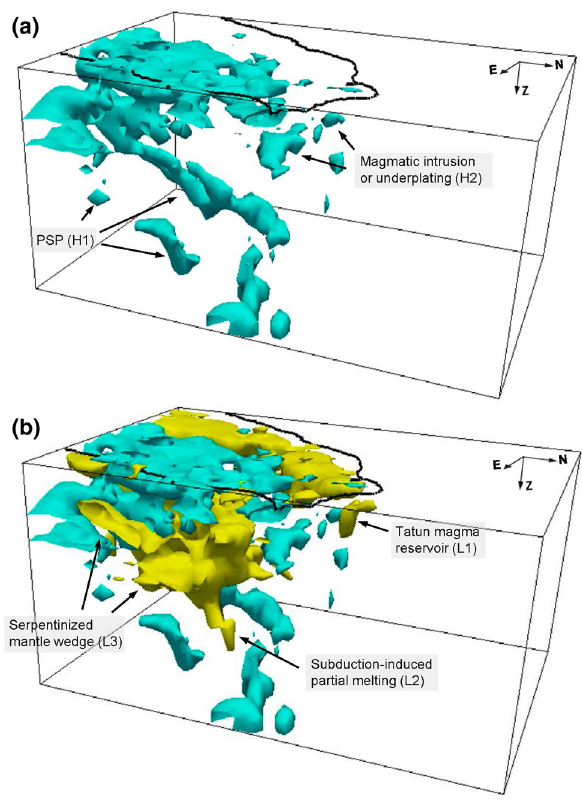
Figure 6. 3-D perspective and interpretations of 3-D velocity structures in the northern Taiwan. Yellow and cyan bodies represent the low and high velocity anomalies with values greater than ±